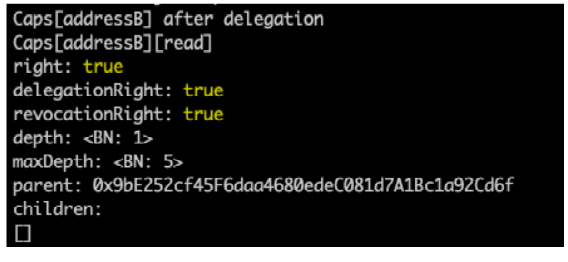
Figure 7. Delegation of read Token from Subjects addressA to addressB